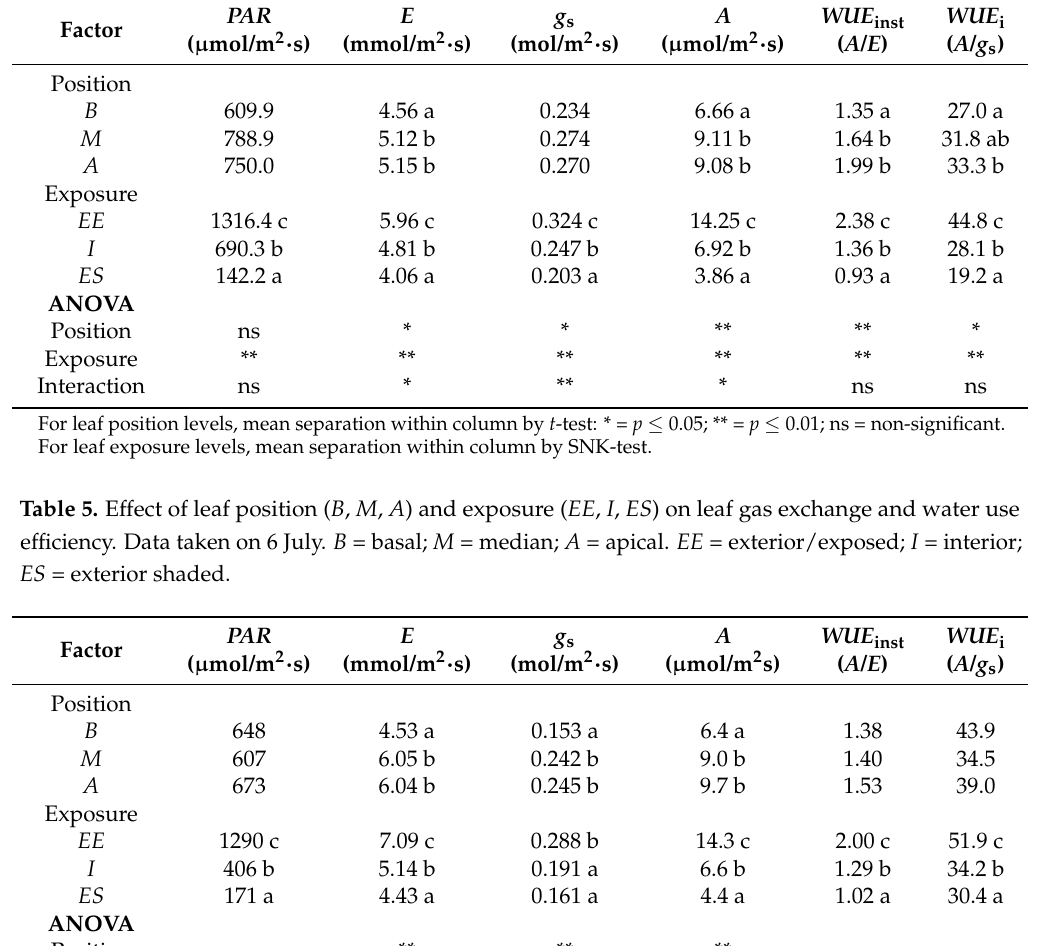
Table 4. Effect of leaf position ( B , M , A ) and exposure ( EE , I , ES ) on leaf gas exchange and water use efficiency. Data taken on 19 June. B = basal; M = median; A = apical. EE = exterior/exposed; I = interior; ES = exterior shaded.